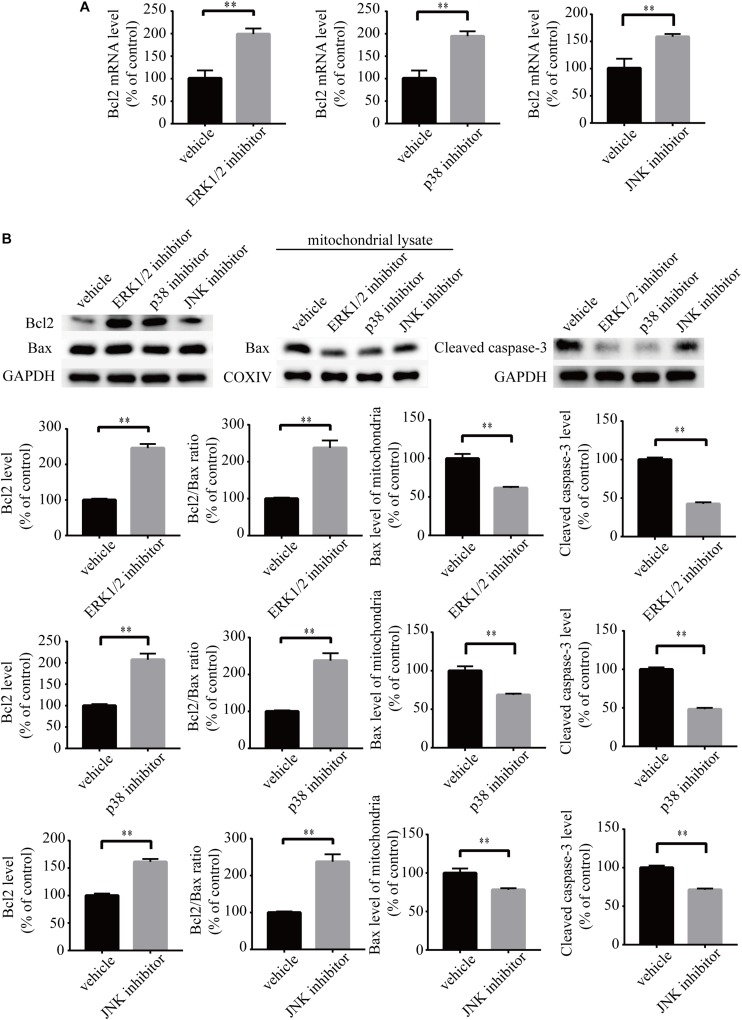
MAPK pathway inhibitors attenuate the decrease of Bcl2 mRNA level, Bcl2 protein level, and Bcl2/Bax ratio as well as the activation of caspase-3. Q-PCR measures the Bcl2 mRNA level in neuronal PC12 cells treated with LPA (A). Western blot detects the Bcl2, Bax, and cleaved caspase-3 protein levels in whole cells as well as the Bax protein level in mitochondria of neuronal PC12 cells (B). Data are mean ± SEM of five independent experiments. ∗∗P < 0.01.